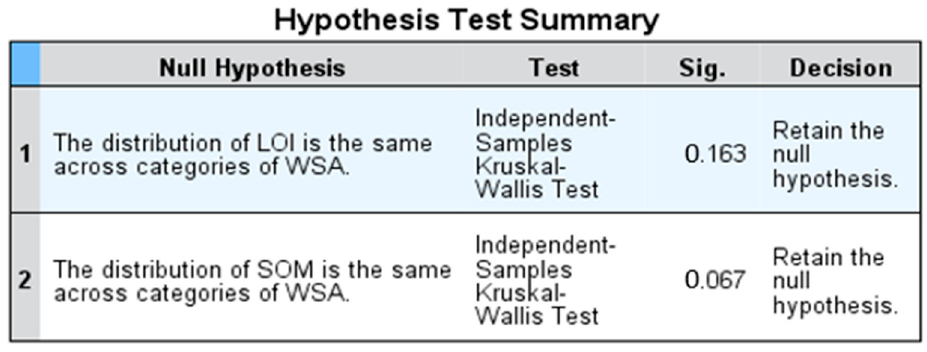
Figure 5. Kruskal–Wallis test results from SPSS.